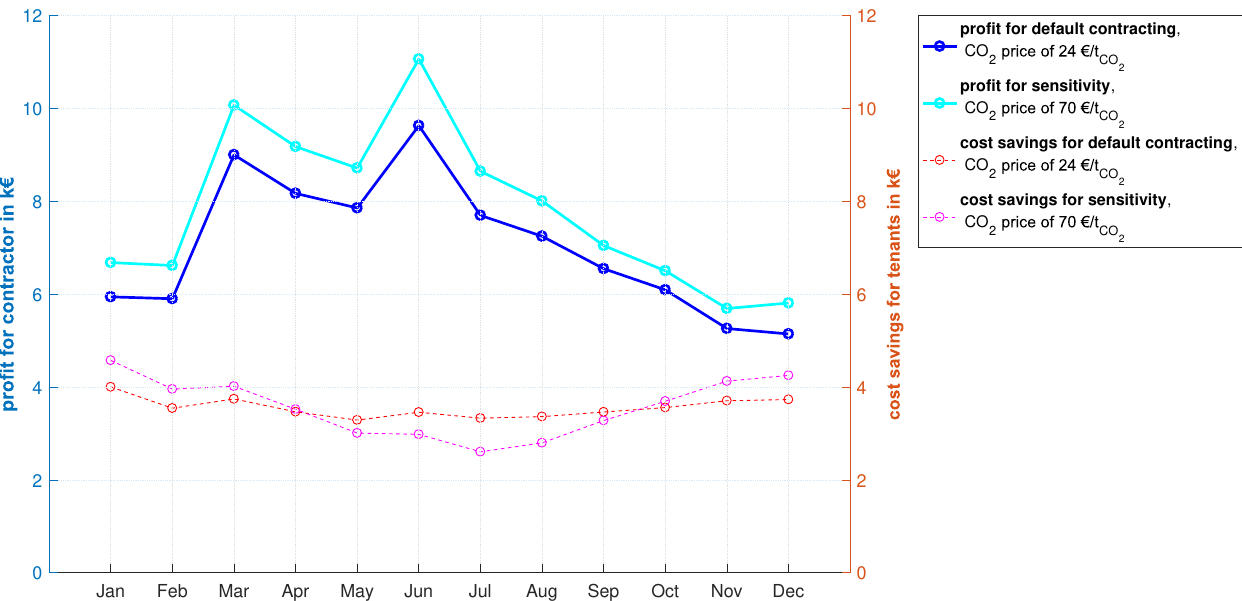
Figure 13. Comparison of monthly profit for contractor and cost savings for residents between default and higher emission costs of 70 e /t CO 2